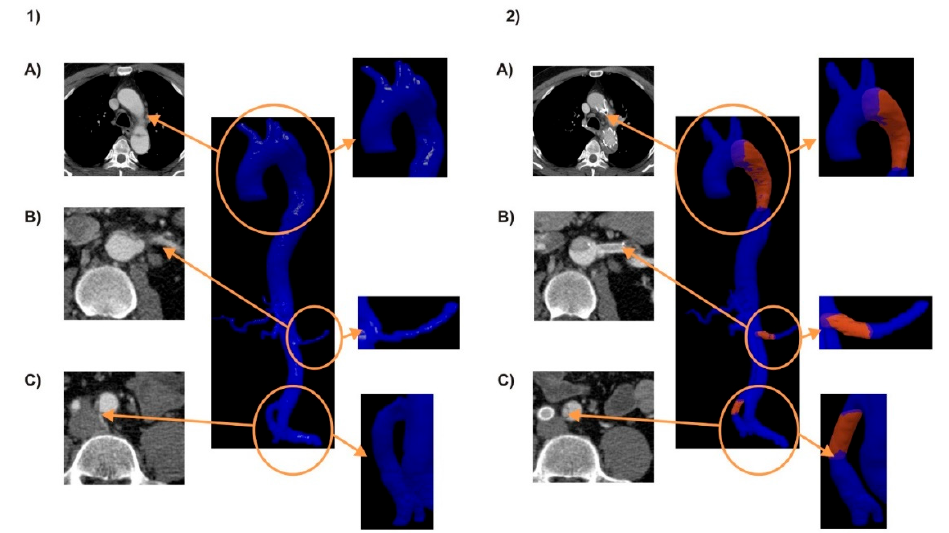
Figure 1. Representative 3D reconstructions of the aorta and aortic branches before ( Panel 1 ) and after ( Panel 2 ) the thoracic endovascular aortic repair (TEVAR) procedure. CTA scans were used to reconstruct the aortic arch ( A ), the left renal artery ( B ), the right common iliac artery ( C ). Blue colour represents aorta, red colour represents aortic stent graft. Post—TEVAR refers to 7 months after operation. 3D reconstructions were performed with ANSYS FLUENT software.